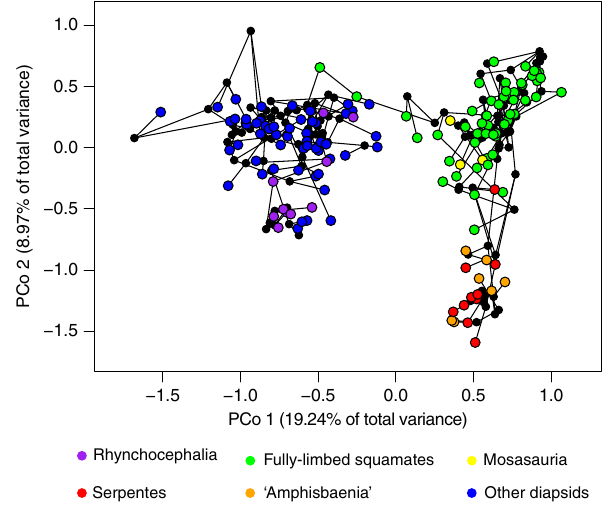
Fig. 5 Phylomorphospace of early diapsid reptiles and lepidosaurs. The fi rst two axes of phenotypic variation among principal coordinates. Early diapsid reptiles occupy a distinct region of the morphospace from lepidosaurs, which in turn, have rhynchocephalians, non-serpentiform squamates, and serpentiform squamates (snakes and amphisbaenians) occupying different regions of the morphospace de fi ned by PCo 1 and